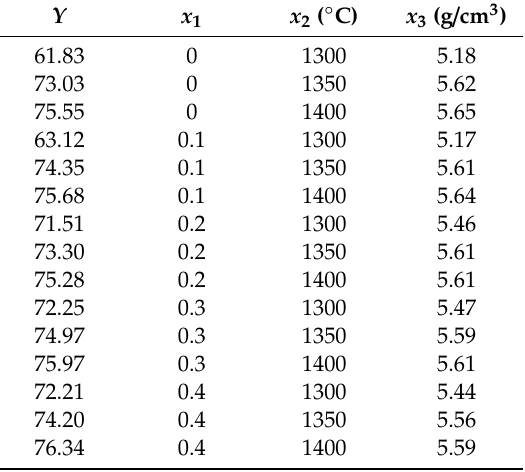
Table 1. Densities and dielectric constants with different Nd contents and sintering temperatures. Y x Y